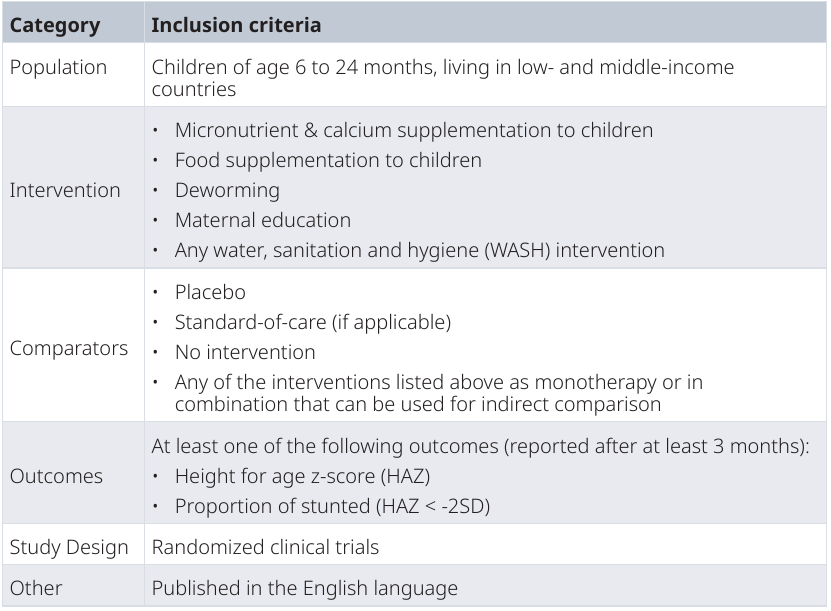
Table 2. Population, interventions, comparator, outcomes, and study design (PICOS)